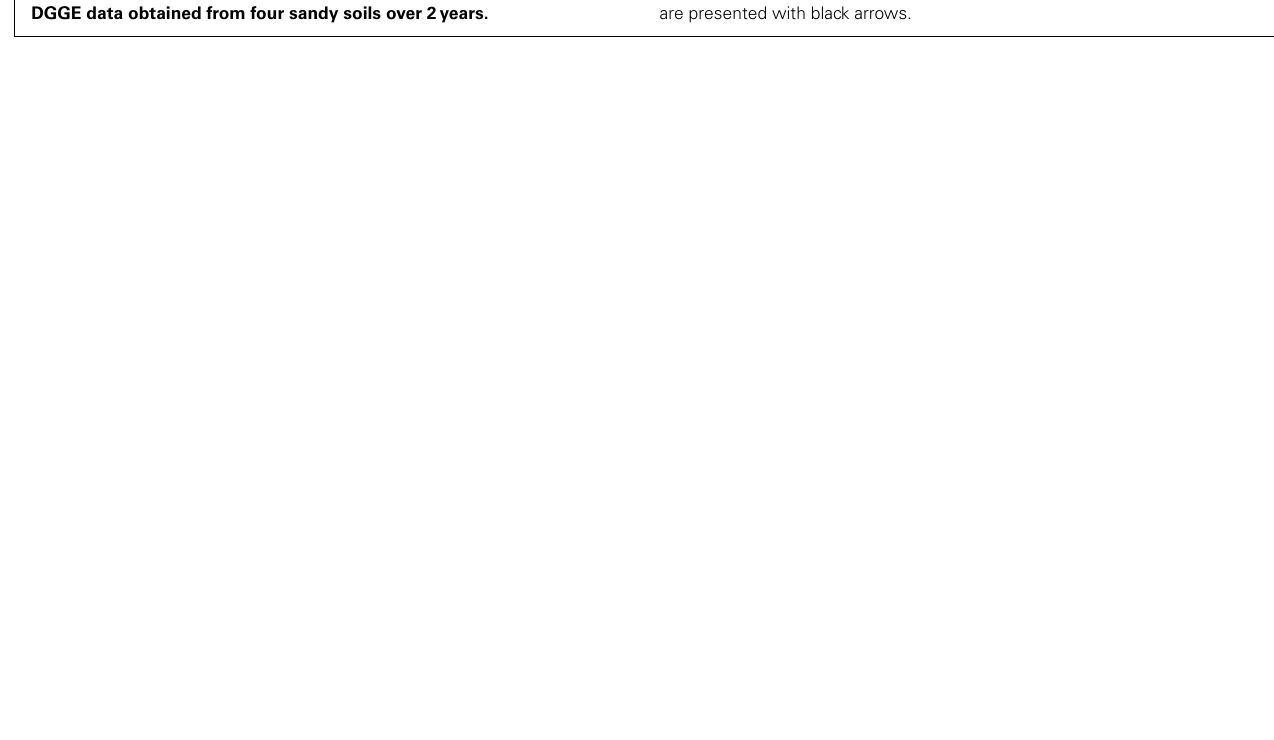
FIGUREA1 | Biplots of canonical correspondence analysis of archaeal amo A gene (A) and beta-proteobacterial 16S rRNA gene (B) from DGGE data obtained from four sandy soils over 2years.